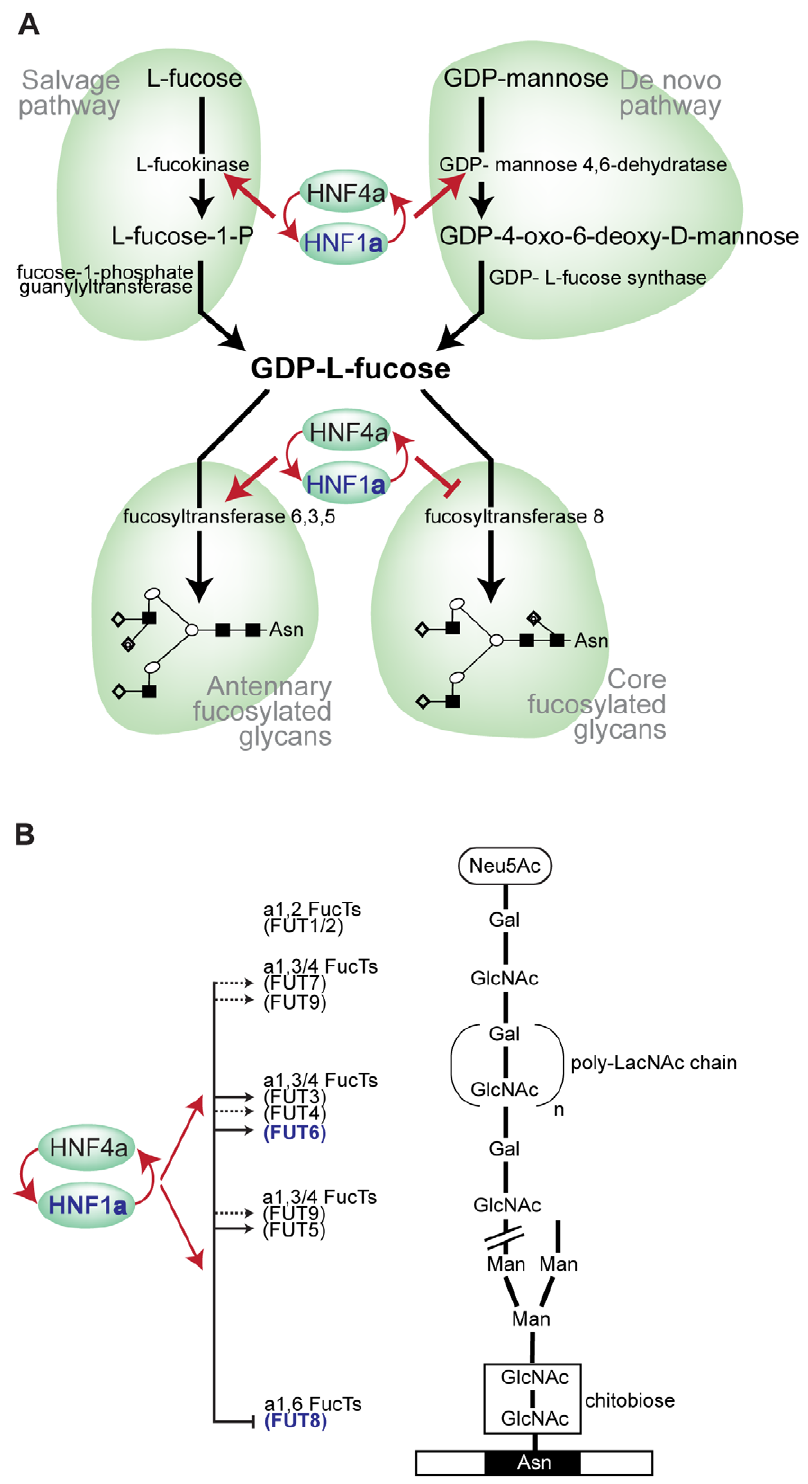
Figure 5. HNF1 a is at the heart of fucosylation regulation. A). Diagram showing HNF1 a and HNF4 a regulation of pathways involved in fucose synthesis. B). Pathways of core (tri-mannosyl-chitobiose) and antennary fucosylation and their proposed regulation by the transcription factors Hnf1 a and Hnf4 a , encoded by the HNF1 a and HNF4 a genes respectively. Red arrows indicate genes that are targets of Hnf1 a /Hnf4 a . Solid lines show direct regulation and dashed lines show indirect regulation of the FUT genes shown. Genes shown in blue depict GWAS identified genes ( HNF1 a , FUT6 and FUT8 ). Abbreviations: Neu5Ac, N-Acetylneuraminic (sialic) acid; GlcNAc, N-acetylglucosamine; Man, mannose; Gal, galactose; poly-LacNAc, Gal b 1,4GlcNAc (LacNAc) antennary chains; Asn, asparagine residue on glycosylated protein.